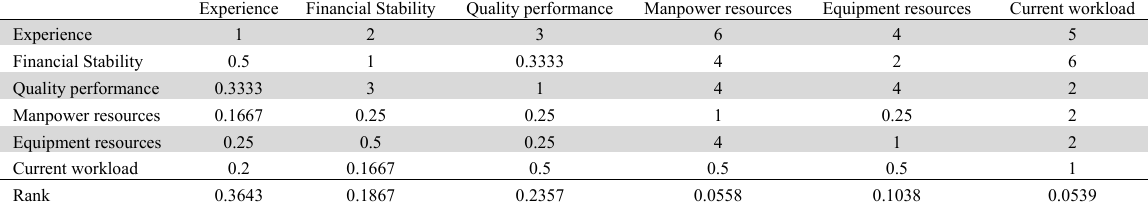
The results of pairwise comparison of different criteria and ranking them using AHP Experience